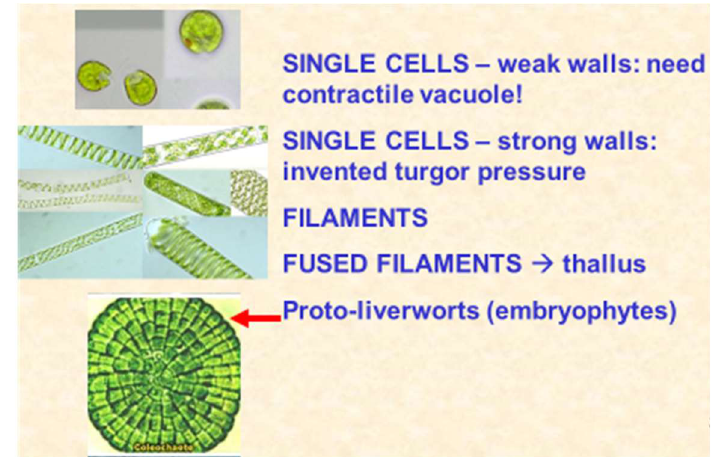
Figure 9. Metaphyte origins. Progression from single cells to filaments that align, forming a flat thallus. The examples here are the biflagellate Chlamydomonas , Spirogyra and the red arrow points to Coleochaete scutata .